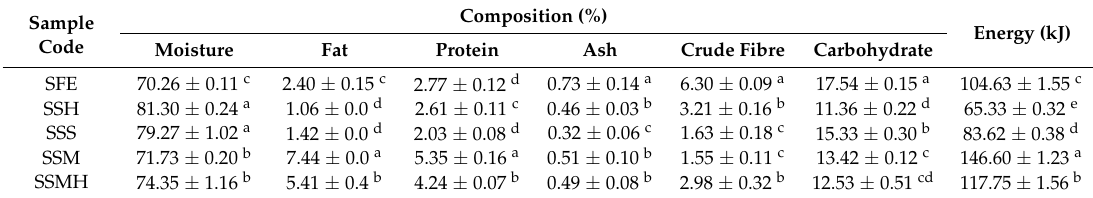
Table 3. Proximate compositions of formulated soursop